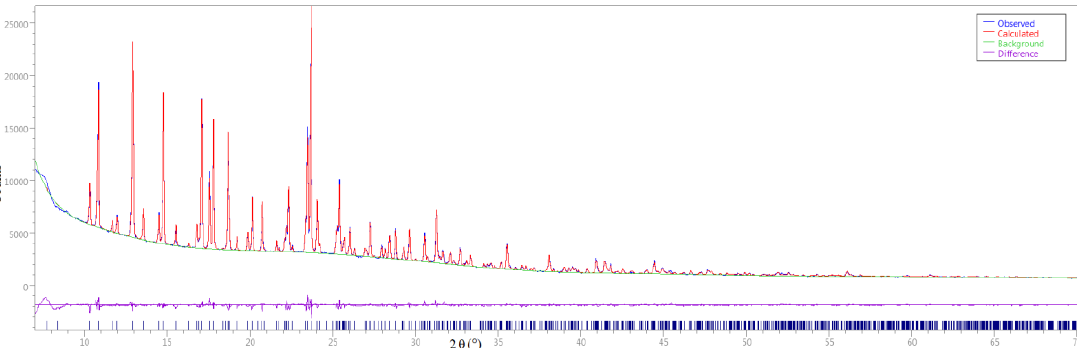
Figure 4. The result of the Rietveld refinement of 5-(5-nitro furan-2-ylmethylen), 3-N-(2-methoxy phenyl), 2- N’ -(2-methoxyphenyl) imino thiazolidin-4-one compound by EXPO: the observed profile (blue line), calculated profile (red line), background (green line) and difference profile (purple line) are shown.